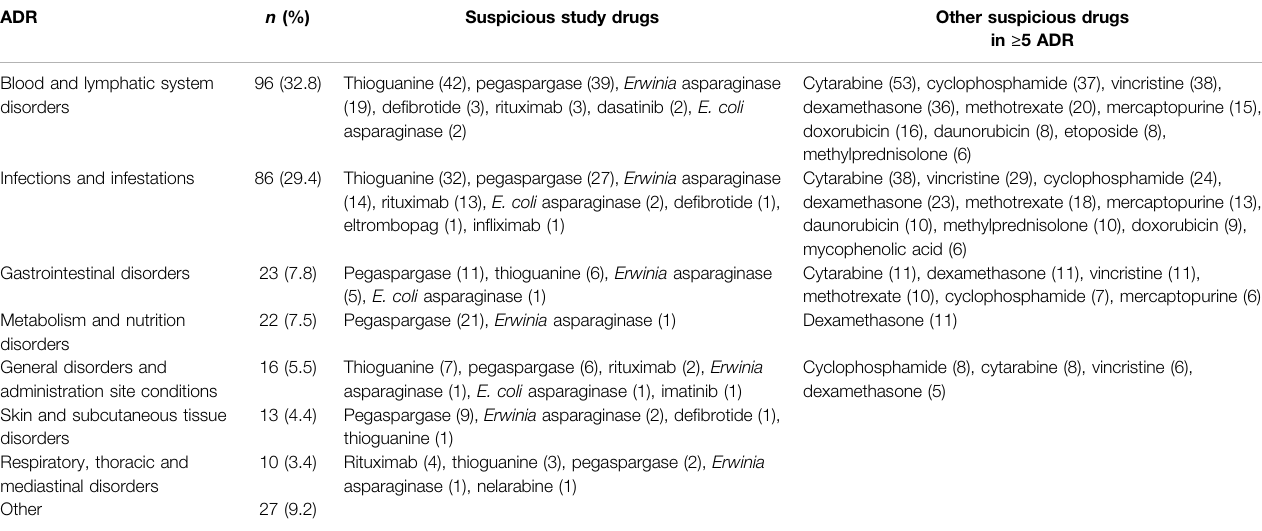
TABLE 4 | Principal ADR according to the affected system and suspicious study drugs a .